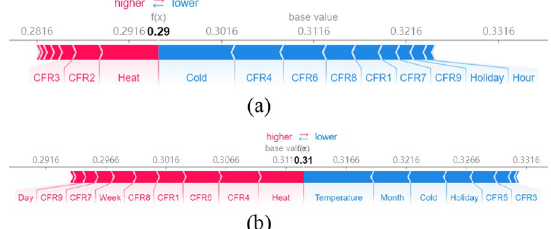
Fig. 9 Local SHAP value distribution of heat load prediction. ( a ) In summer. ( b ) In winter